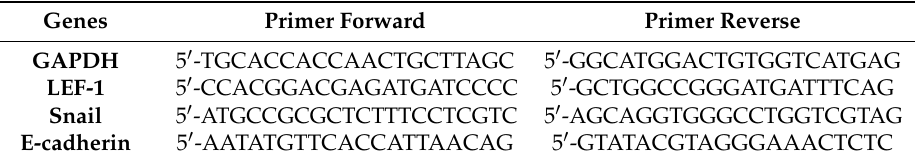
Table 1. List of primers used for Real-Time PCR